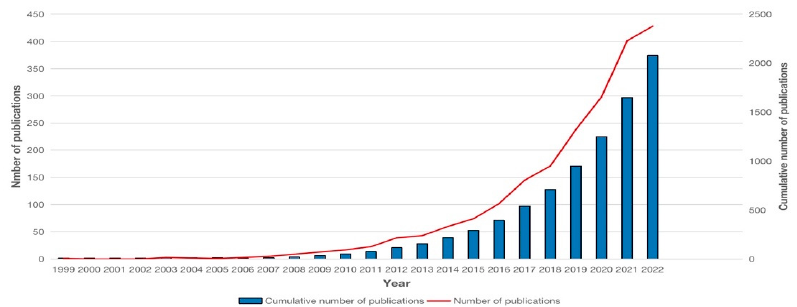
Figure 2. Publication years of nano-drug sustained release system research in wound healing.